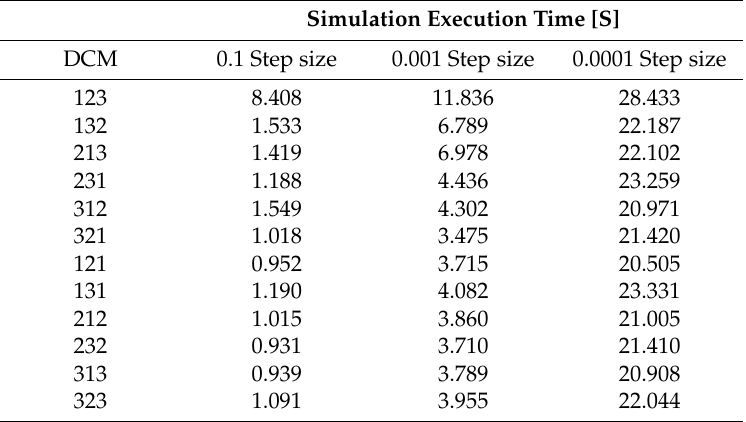
Table 2. Simulation run times for all 12 Direction Cosine Matrices (DCM) rotations for a 30 ◦ roll maneuver, using 0.1, 0.001, and 0.0001 step